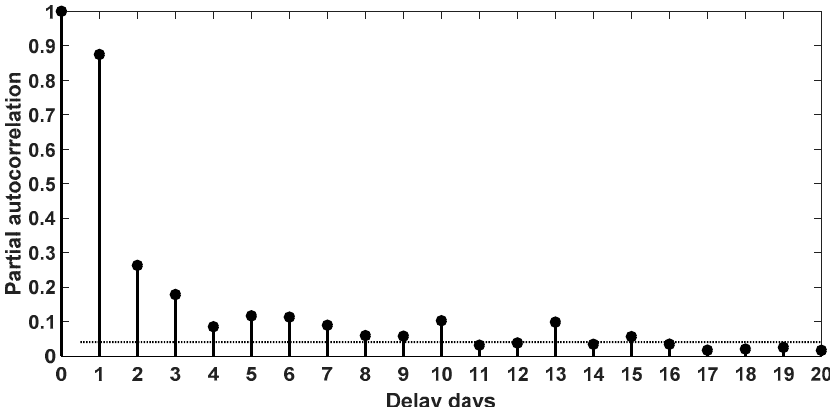
Figure 7. Partial autocorrelation coefficients of the weighted moving mean model, for time delays of 1–20 days with the data of seven years of horizontal daily global solar irradiation.